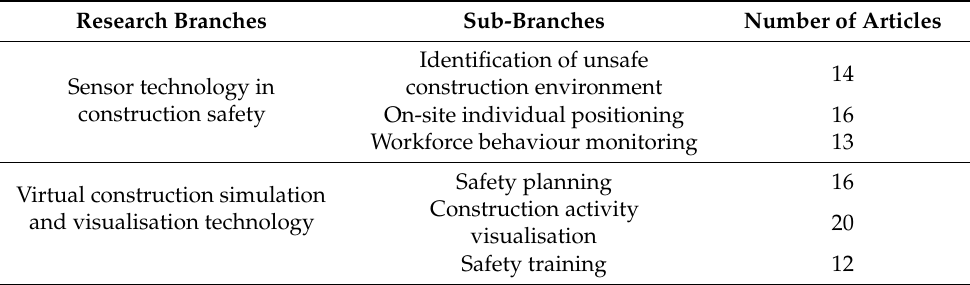
Table 1. Number of articles in different research branches.